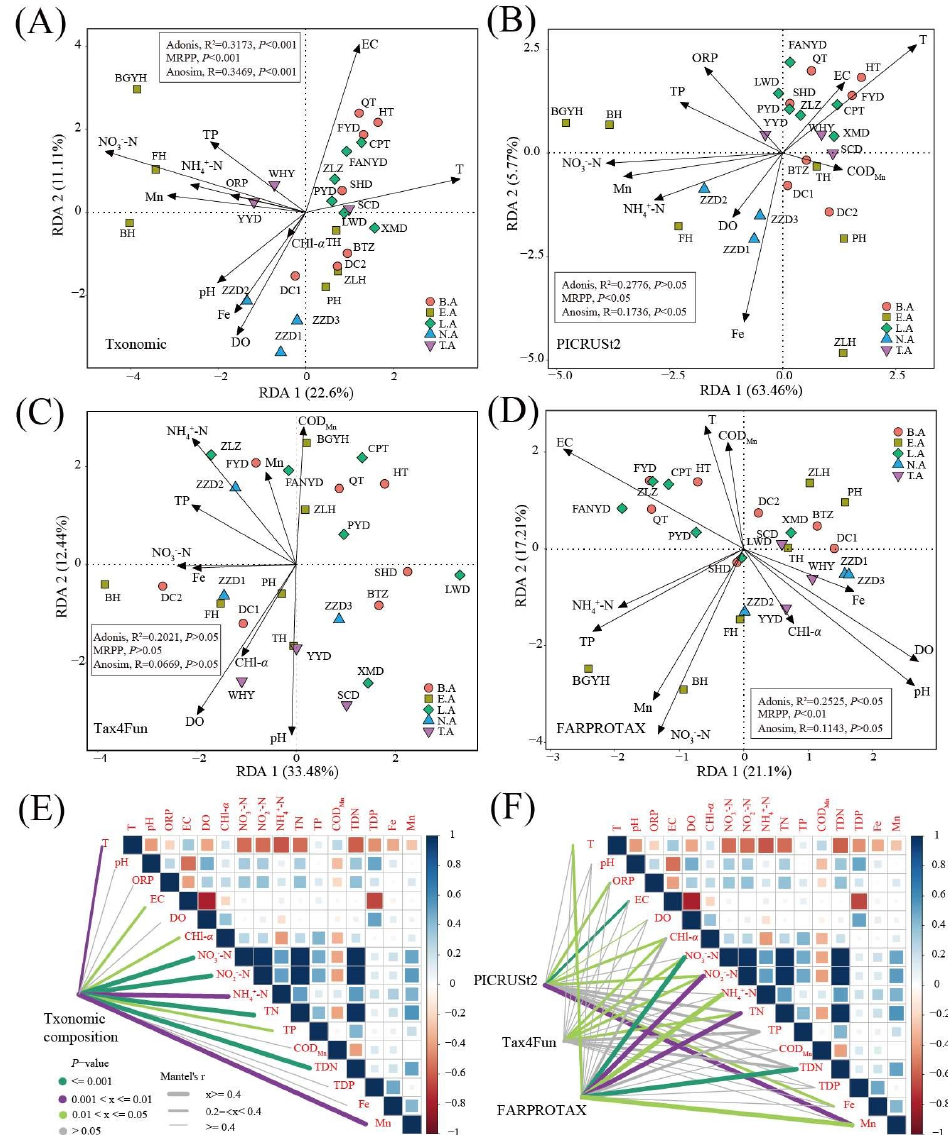
Figure 5. RDA, and Mantel test of taxonomic community and functional community in Baiyangdian Lake. ( A ) RDA of taxonomic community; ( B ) RDA of functional community based on PICRUSt2; ( C ) RDA of functional community based on Tax4Fun; ( D ) RDA of functional community based on FARPROTAX; ( E ) Mantel test between taxonomic community and environment factors; ( F ) Mantel test between functional community and environment factors.